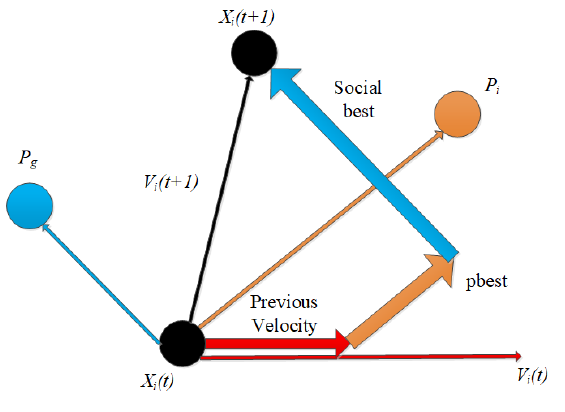
Figure 2. PSO—velocity vector